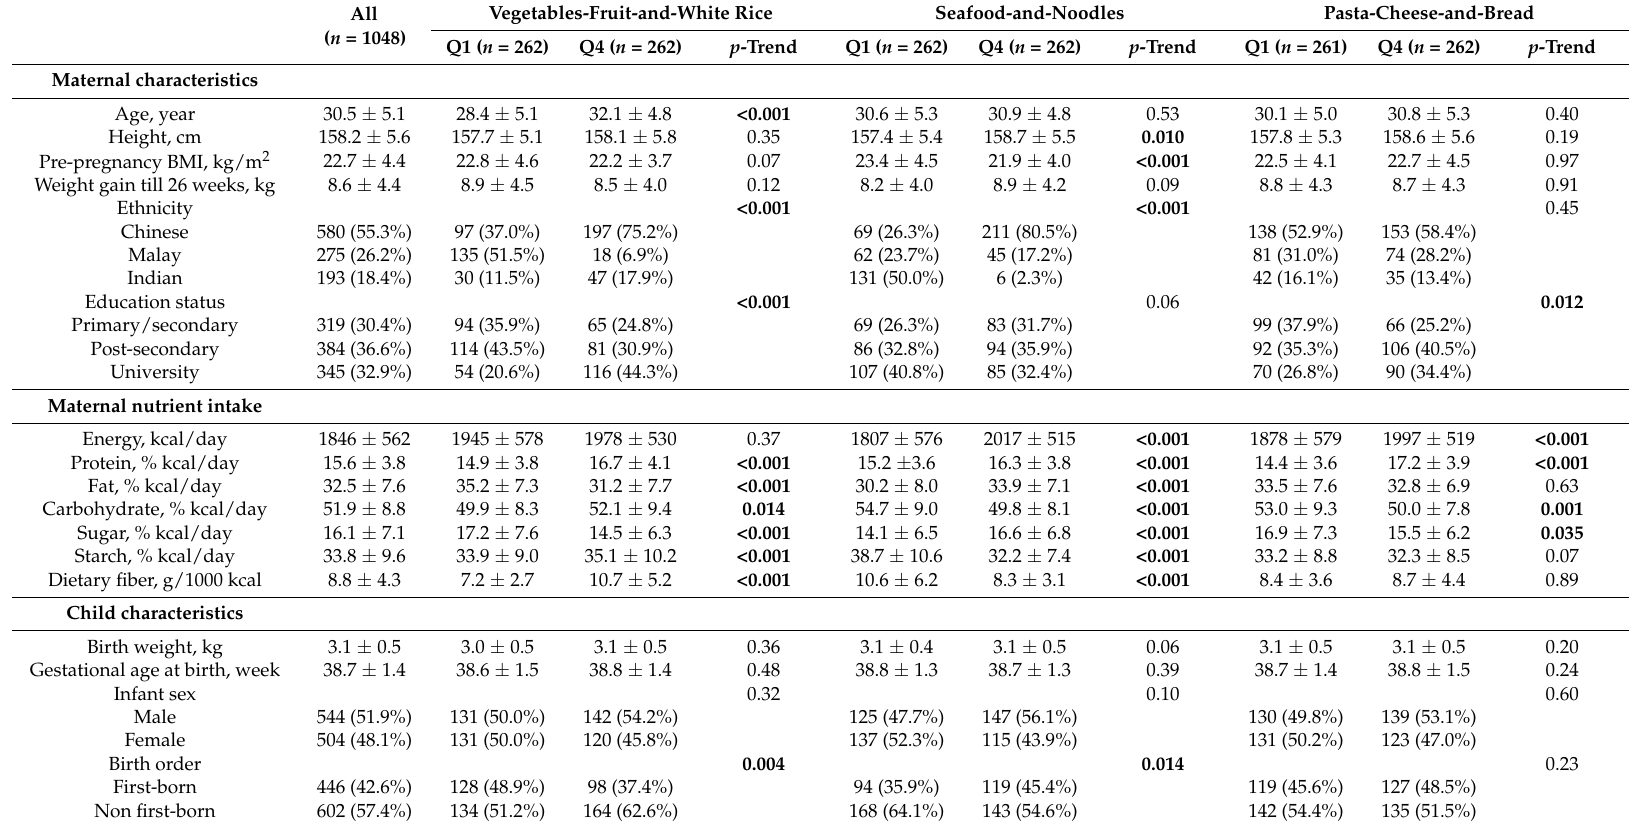
Table 2. Maternal and child characteristics according to quartiles of maternal dietary pattern scores 1